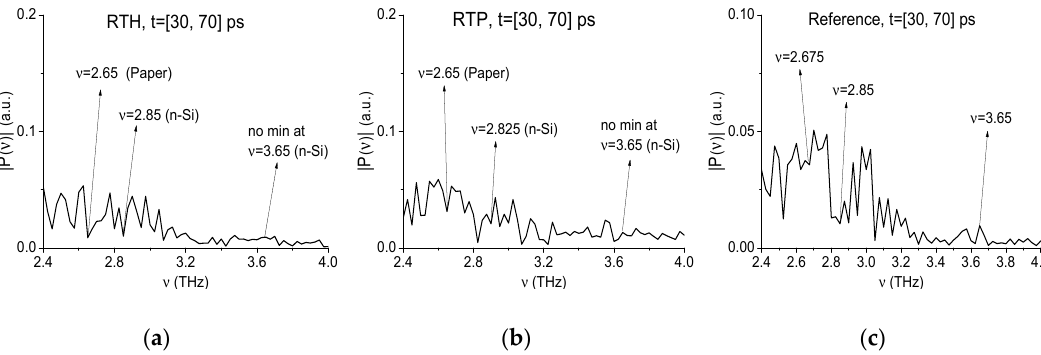
Figure 25. Spectra of the RTH ( a ), RTP ( b ) signals and reference ( c ) computed in the time interval t = [30, 70] ps, in the frequency range ν = [2.4, 4.0] THz.